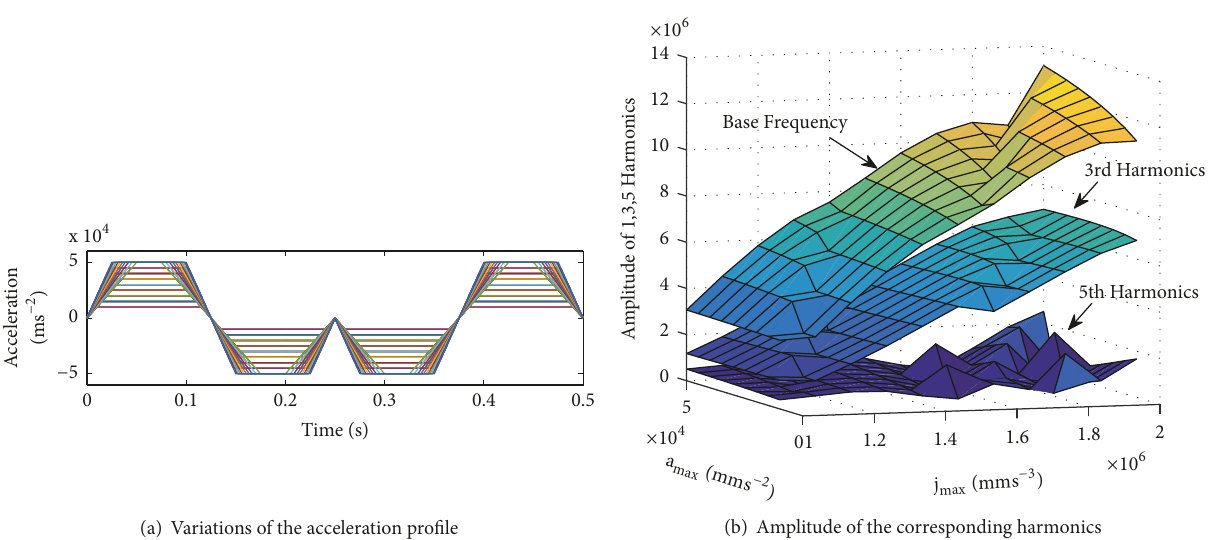
Figure 5: An example illustrating the relation between the dynamic motion parameters and amplitude-frequency characteristics.